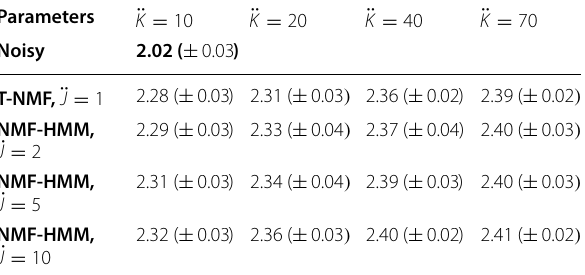
Table 4 Average PESE scores (%) comparisons of different noise states and basis vectors ( J = 40, K = 25 )